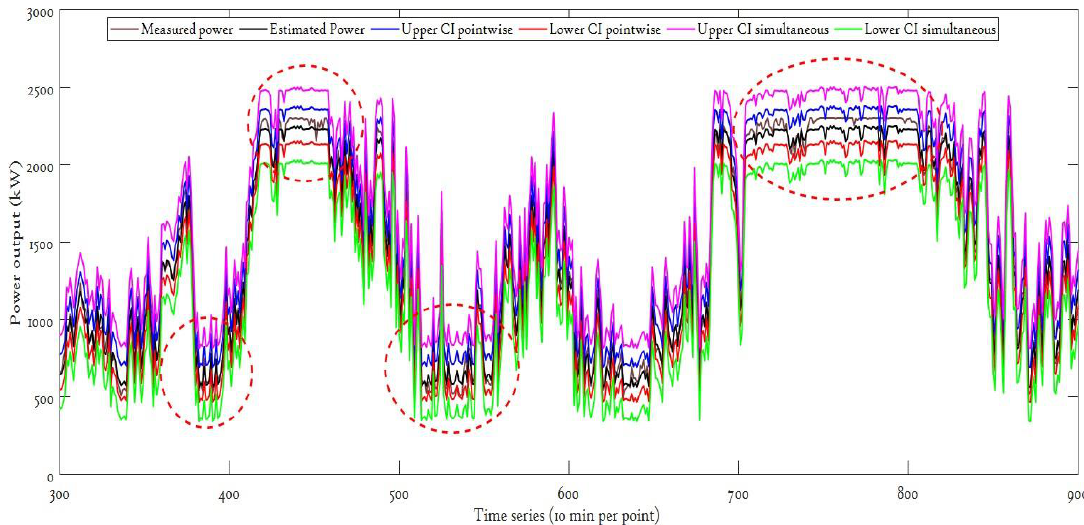
Figure 12. Comparative studies on SVM models in terms of time-series.